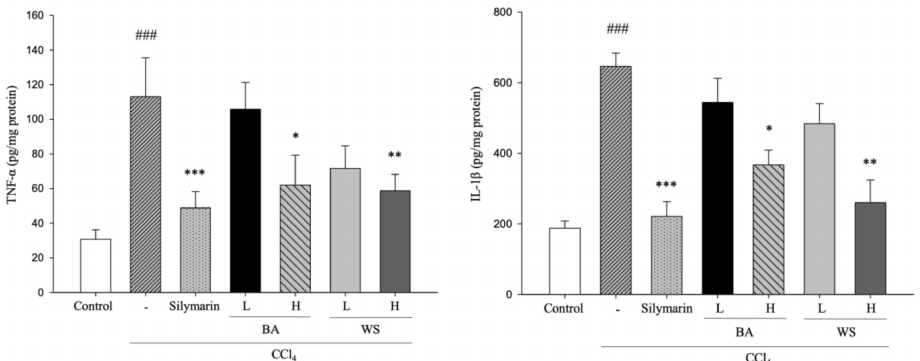
Figure 3. Effect of different fractions of black garlic and silymarin on hepatic TNF- α and IL-1 β in mice treated with CCl 4 . Each value represents as mean ± S.E.M. ( n = 10). ### p < 0.001 as compared with the control group. * p < 0.05, ** p < 0.01, *** p < 0.001 as compared with the CCl 4 group (one-way ANOVA followed by Scheffe’s multiple range test).